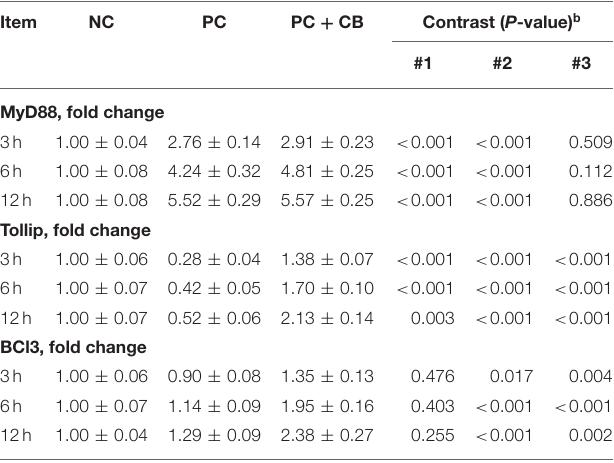
TABLE 6 | Effect of CB on the mRNA expression of key proteins in TLRs/NF- κ B inflammatory signaling a